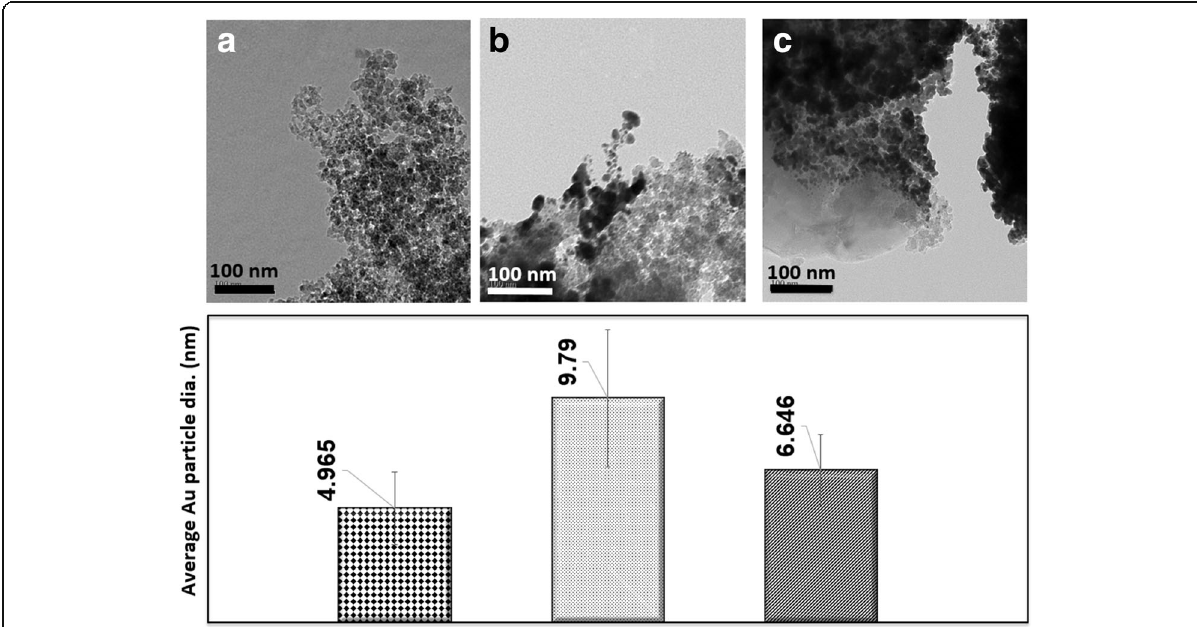
Fig. 11 Average gold particle diameters in nanometers of samples gold sputtered for 8 min. a 1 OL 0.025 mm, b 5 OL 0.025 mm, c 5 OL 0.15 mm